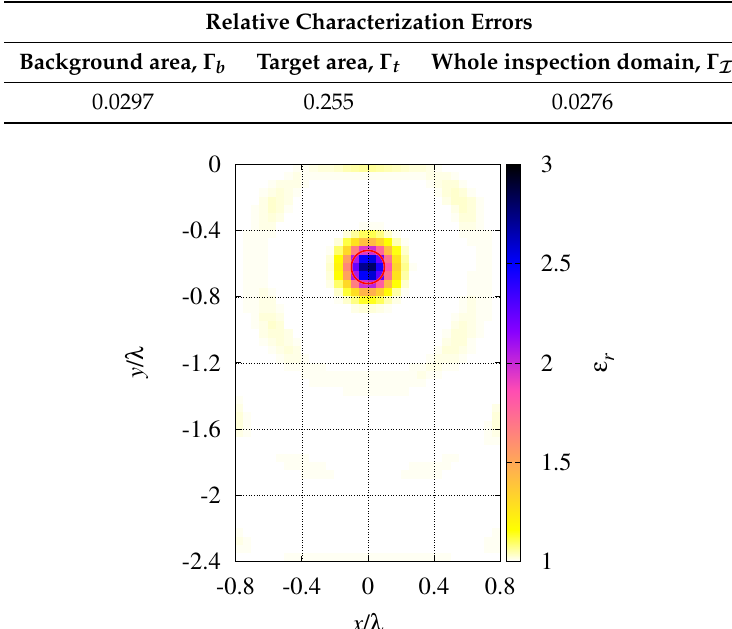
Table 6. Relative Errors on the Dielectric Characterization from Experimental Data.